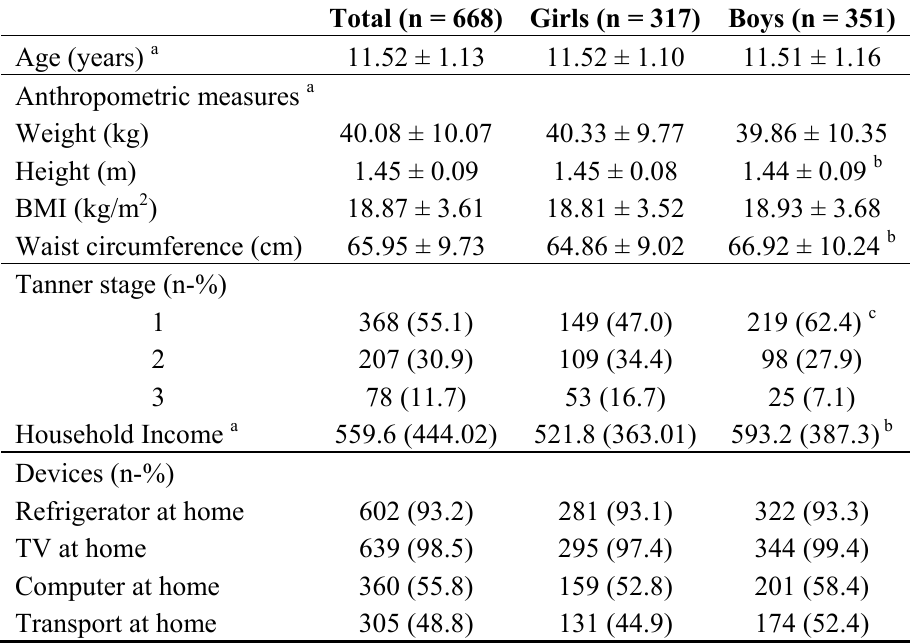
Table 1. Demographic and anthropometric